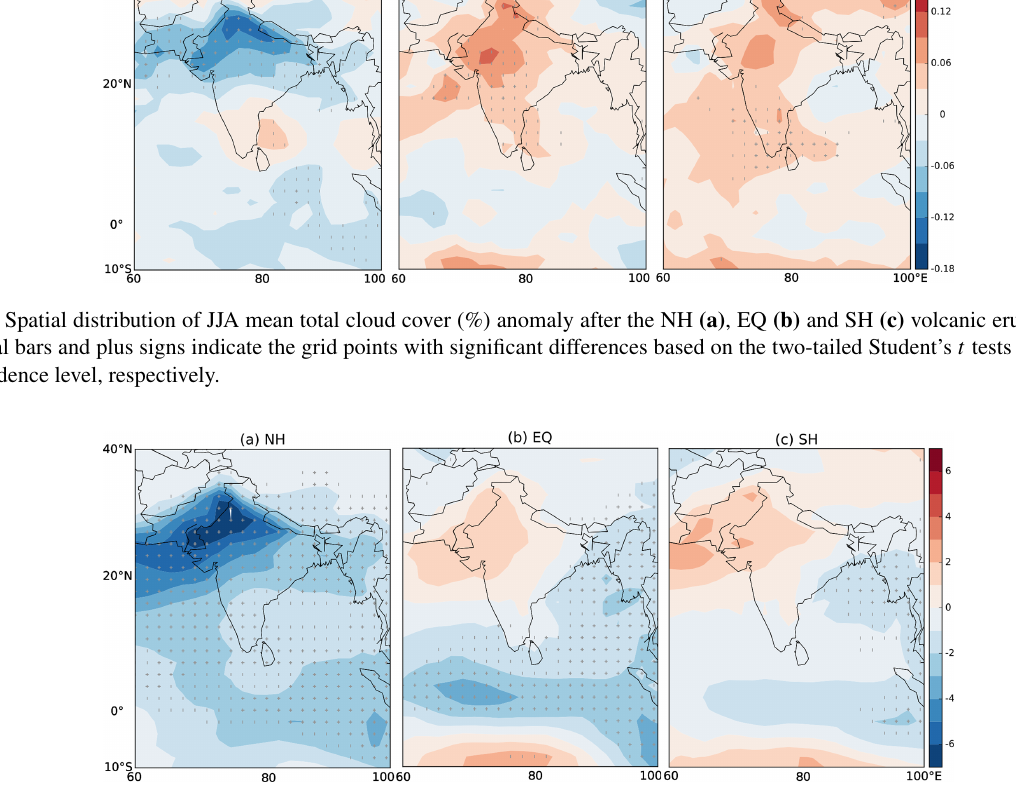
Figure 11. Spatial distribution of JJA mean vertical integrated water vapor (kgm − 2 ) anomaly after the NH (a) , EQ (b) and SH (c) summer volcanic eruptions in 1992. The vertical bars and plus signs indicate the grid points with significant differences based on two-tailed Student’s t tests at the 95% and 99% confidence level,